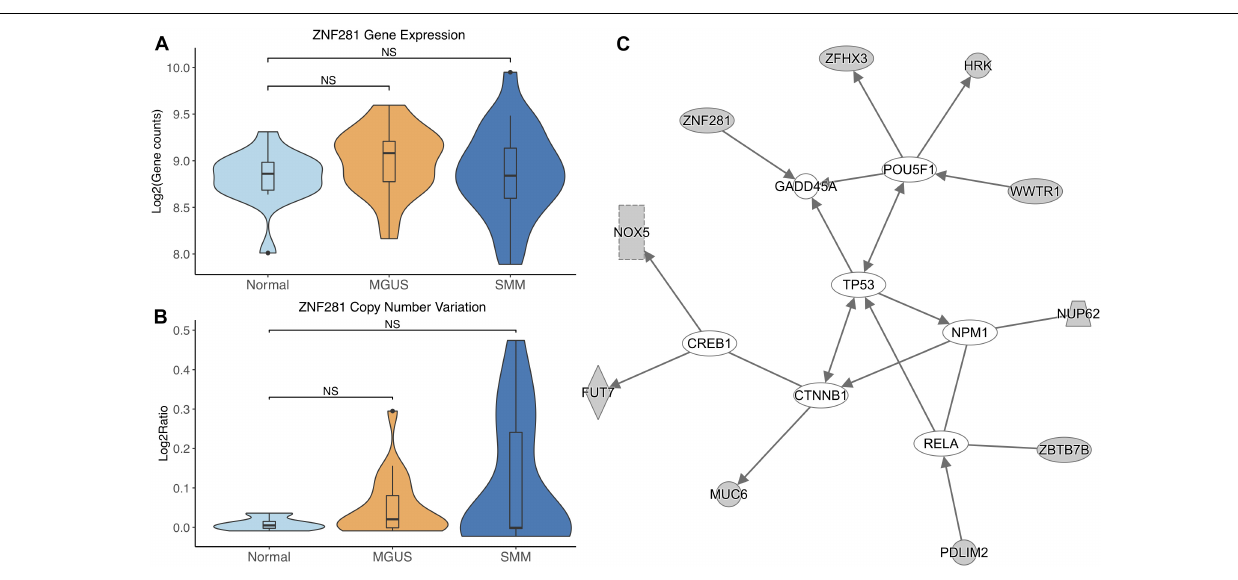
FIGURE 6 | (A) ZNF281 expression across sample groups. Mann–Whitney tests between groups showed no significant difference. (B) Observations of ZNF281 copy number. Mann–Whitney tests showed no significant differences between any groups. (C) A predicted interaction network of ZNF281 and its downstream targets. The gray nodes indicate genes from our module and the white nodes are gene interactions defined in IPA. Solid lines between nodes indicate a direct interaction supported by the Ingenuity Knowledge Base. Significance levels: ∗ p ≤ 0.05; ∗∗ p ≤ 0.01; ∗∗∗ p ≤